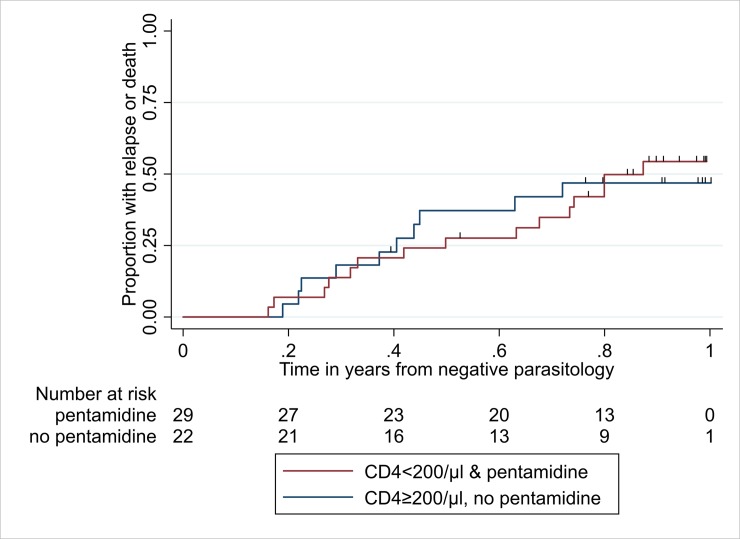
Kaplan-Meier curve for relapse or death, for the two groups shown in Table 3: a) CD4 <200 cells/μL cells and pentamidine; and b) CD4 ≥200 cells/μL cells without pentamidine. Overall, the median follow-up time was 0.77 years (9.2 months, range: 0.16–1.00 years). Median (range) follow-up time; CD4 <200 cells/μL & pentamidine: 0.80 years (9.6 months, 0.16–0.99 years); CD4 ≥200 cells/μL, no pentamidine: 0.74 years (8.9 months, 0.19–1.00 years). Thus, by one year all but one of the patients had either relapsed (n = 21), died (n = 4), or been censored (n = 25). The short vertical lines above each of the Kaplan-Meier curves shows the times at which censoring occurred. A large proportion of patients were censored because the scheduled time of follow-up in the cohort was 390 days minus the time between initiation of VL treatment and achieving negative parasitology (see ‘Follow-up’ subsection of Methods). This figure shows proportions while the regression analysis in Table 4 is based on rates per person-year. The numerical values of the proportions differ from those of the rates, but the approaches are consistent and complementary, as explained in footnote g of Table 4.